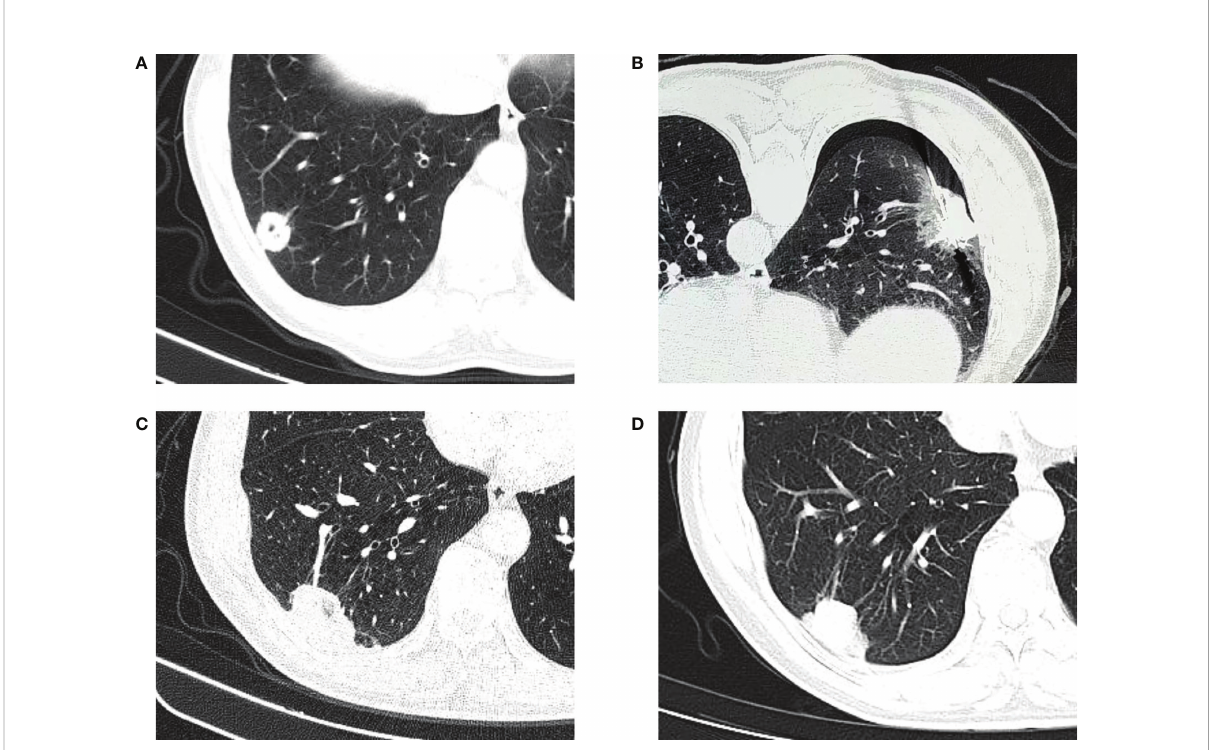
FIGURE 2 CT-guided percutaneous RFA. (A) CT scan performed before RFA, showing a lesion in the lower right lobe. (B) CT − guided percutaneous RFA of the lesion. (C) CT scan performed 1 month after the procedure. (D) CT scan performed 4 months after the